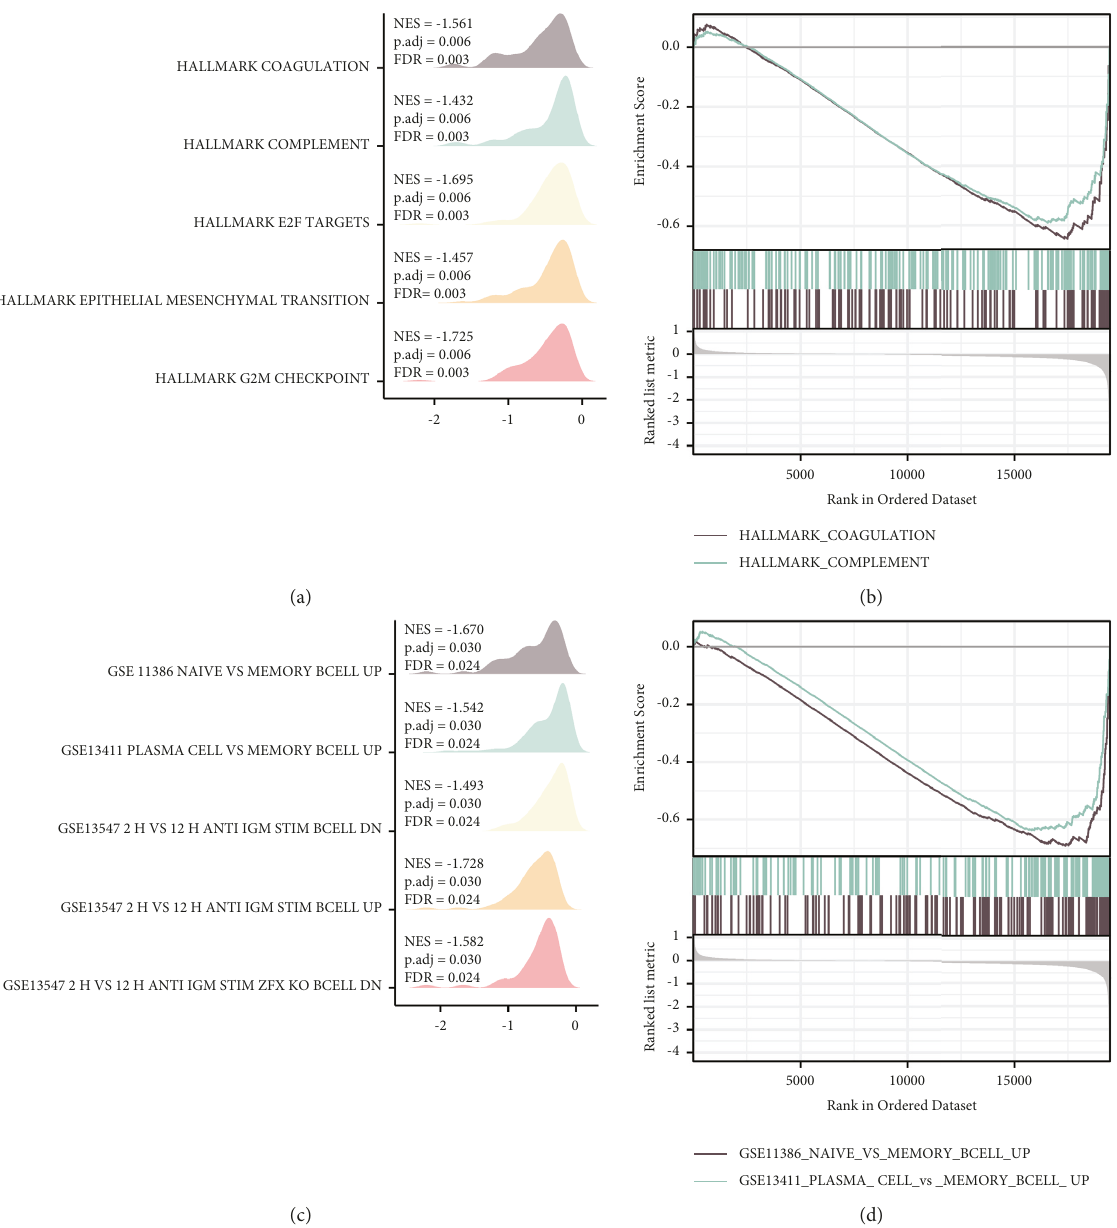
Figure 5: GSEA analyses between keloid lesions and nonlesion keloids based on annotations from hallmark gene sets and c7: immunologic signatures from the molecular signatures